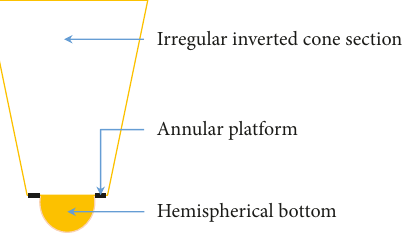
Figure 3: Schematic of the erosion